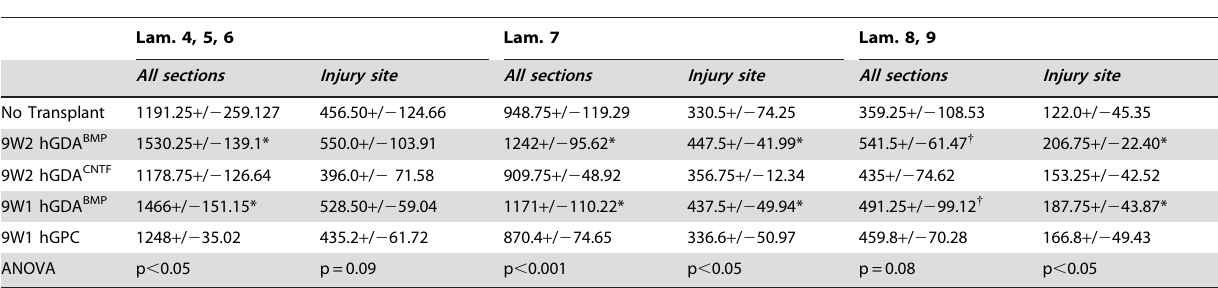
Table 2. Lamina-specific analysis of spinal cord neuron